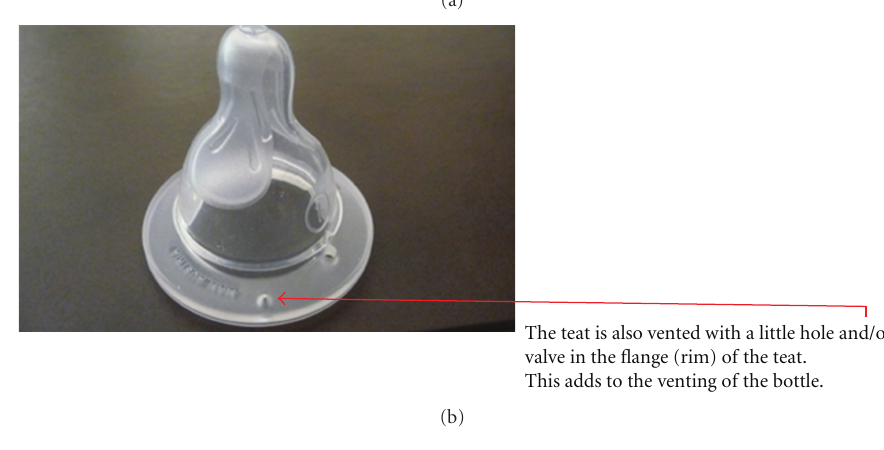
Figure 2: (a) New Bottle design. (b) The new bottle’s nipple.